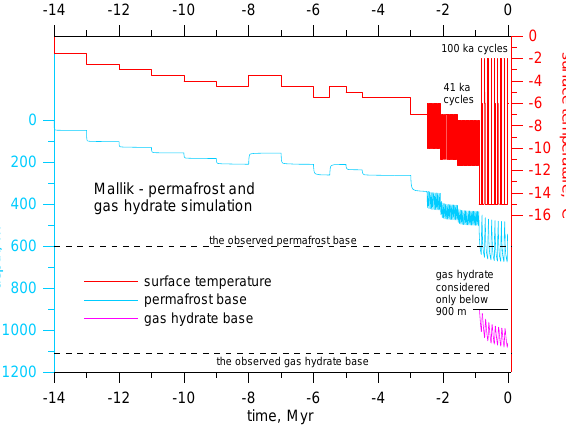
Fig. 5. Case 1 model results for the entire 14 Myr history of surface temperature forcing showing both the time dependence IBP and GH base depth variations.